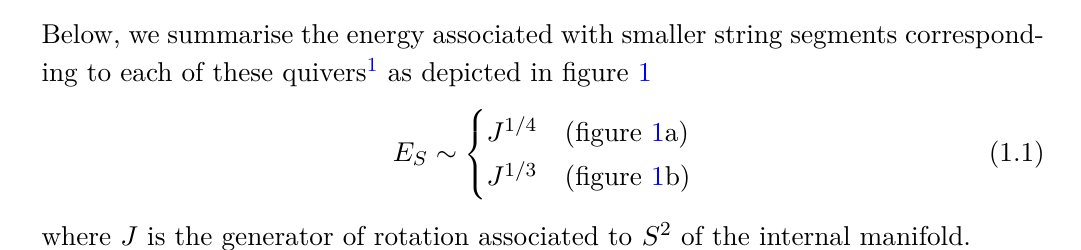
(a) Folded String